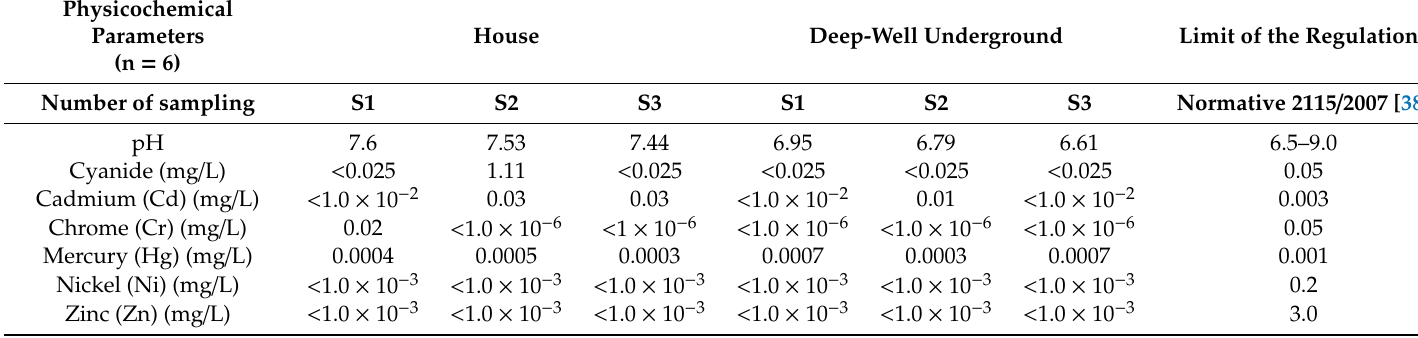
Table A2. Results of physicochemical parameters analysis compared with the normative 2115 of